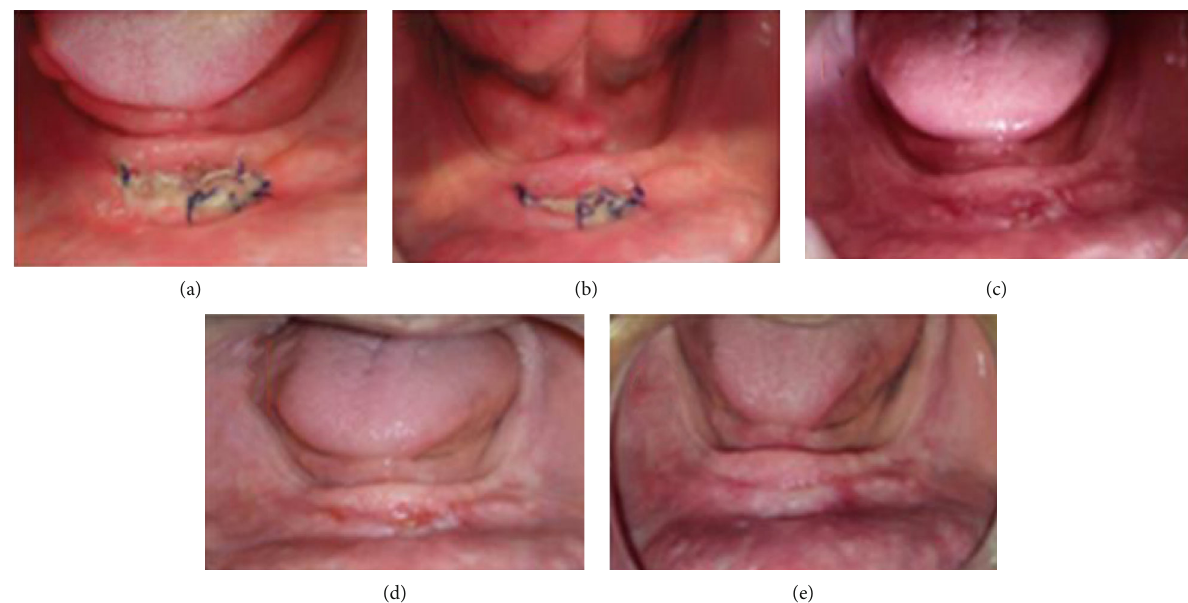
Figure 21: Healing process of the treated area: (a) 3 days, (b) 1 week, (c) 2 weeks, (d) 3 weeks, and (e) 4